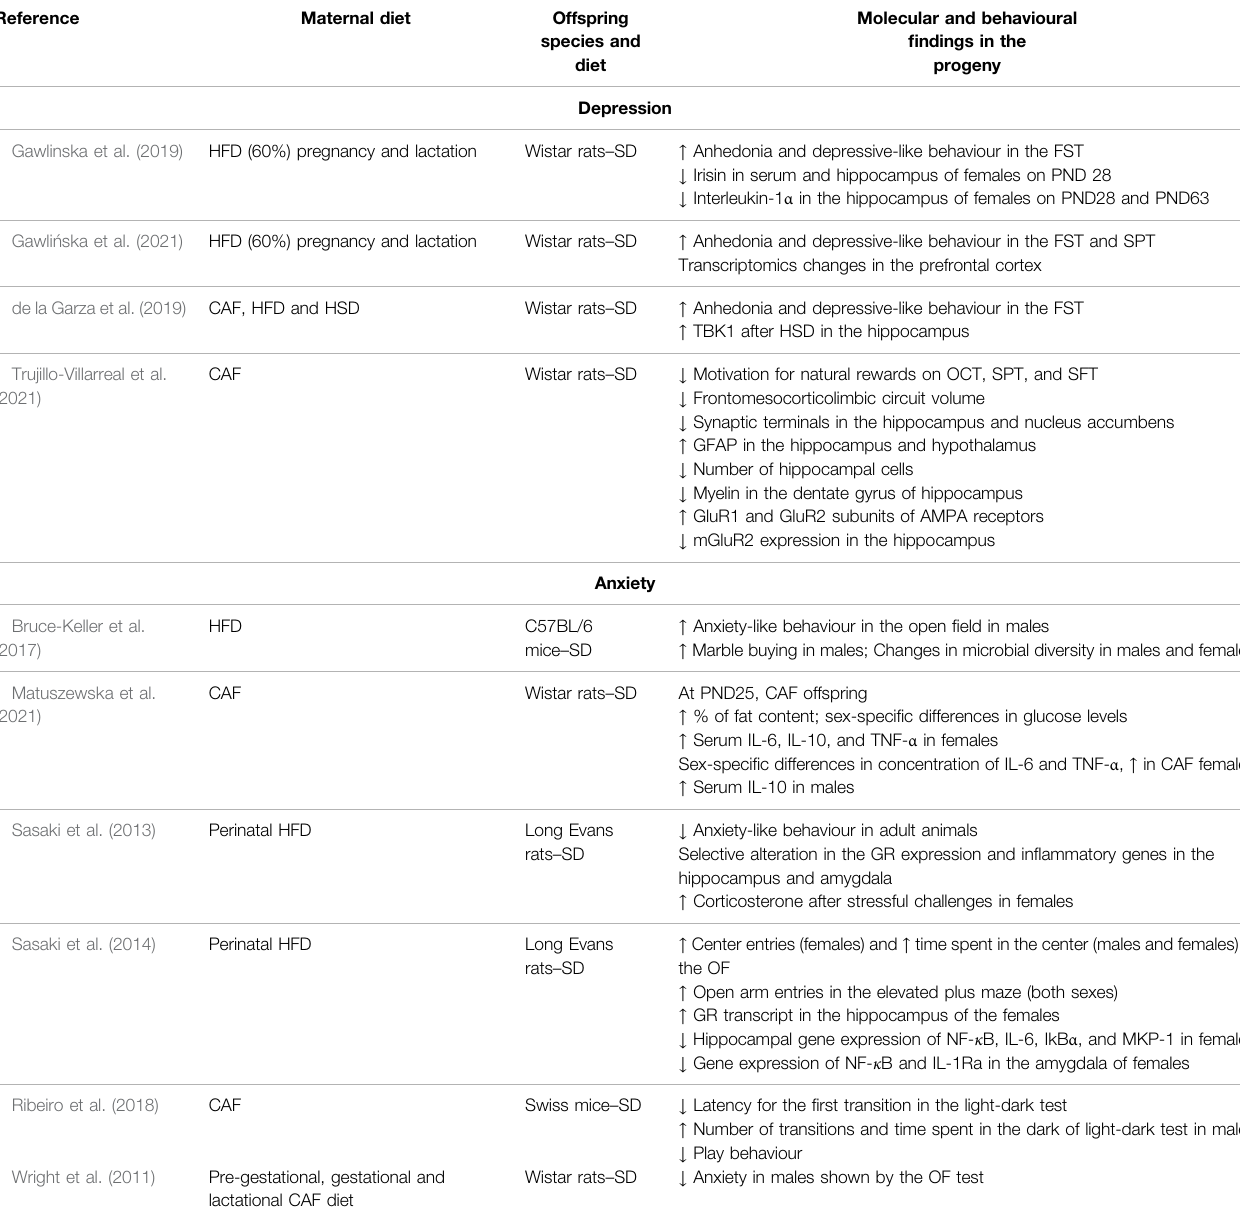
TABLE 1 | Effects of maternal nutrition on depressive and anxious-like behaviour and reported mechanisms in preclinical studies.